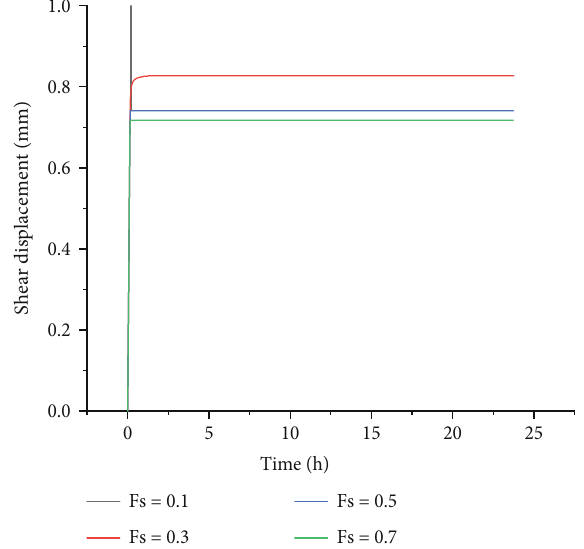
Figure 15: Shear displacement-time curves of di ff erent F